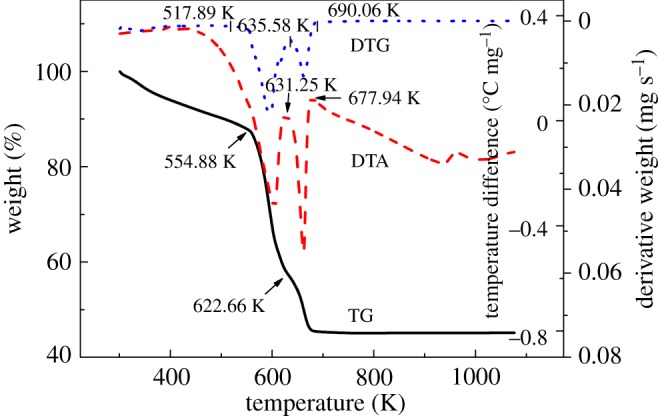
TG–DTA /DTG plots for hafnium n-propoxide (10 K min−1, 100 ml min−1, N2).